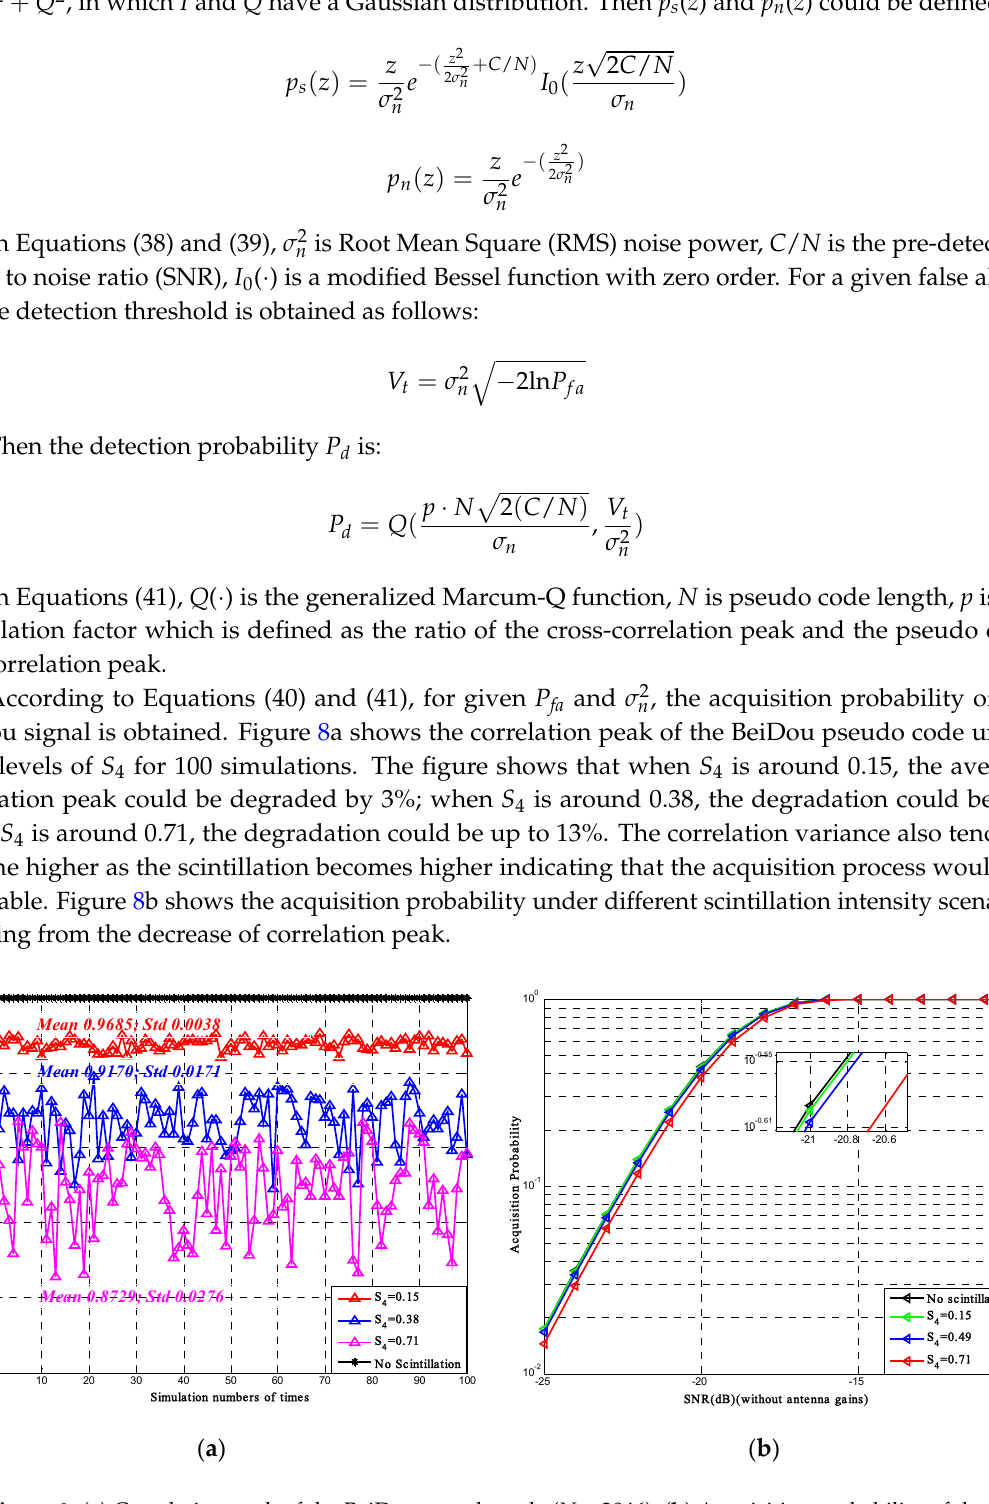
Figure 8. ( a ) Correlation peak of the BeiDou pseudo code ( N = 2046); ( b ) Acquisition probability of the BeiDou signal ( N = 2046).